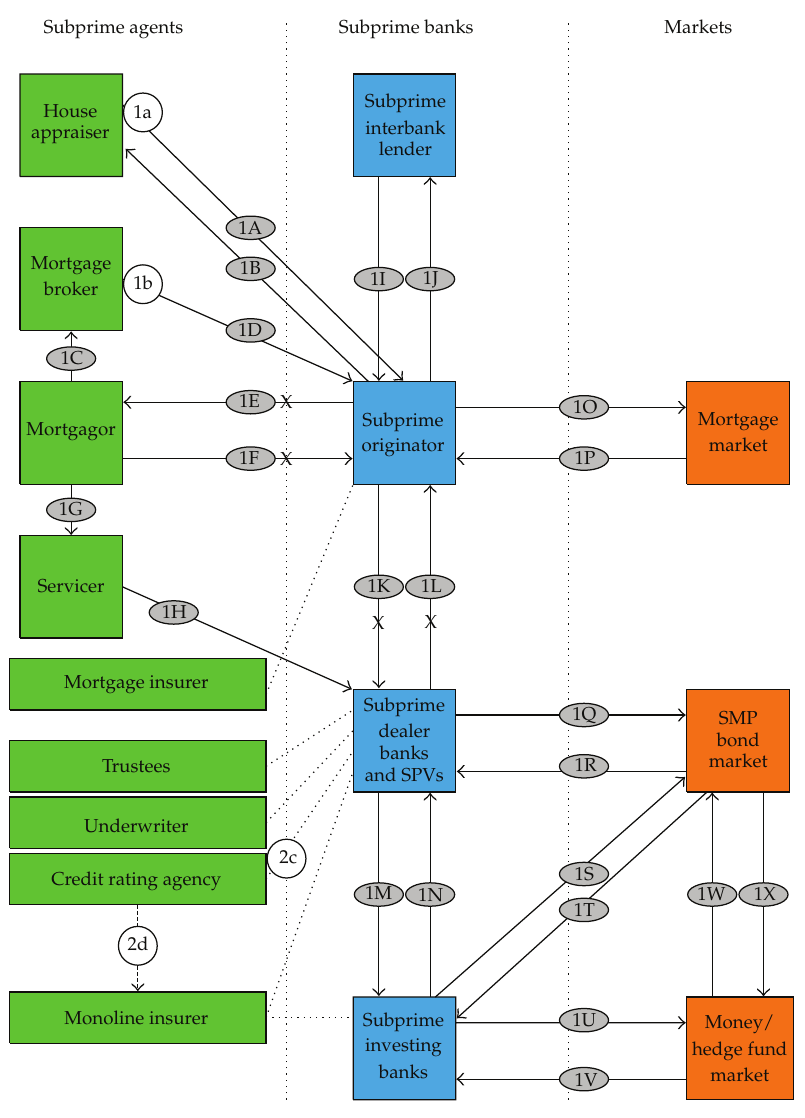
Figure 1: A subprime mortgage model with